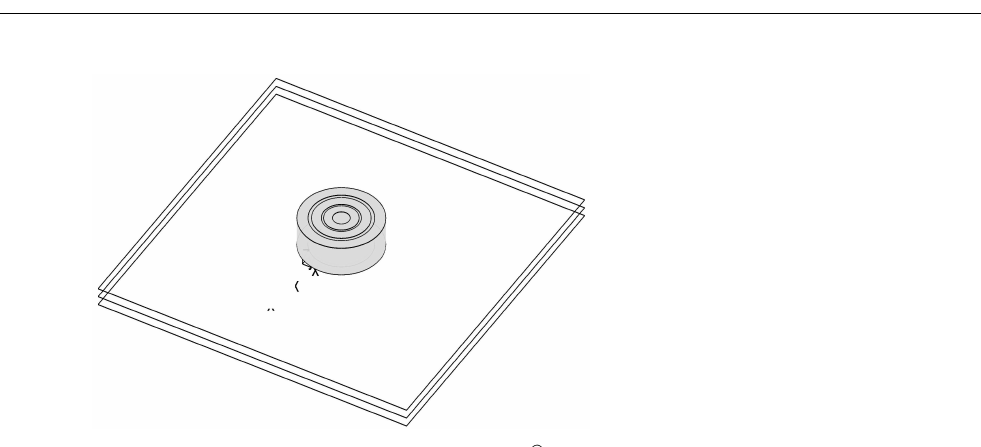
Figure 4. CFRP plate simulated by COMSOL ® Multiphysics (the three parallelepipeds superimposed represent three different